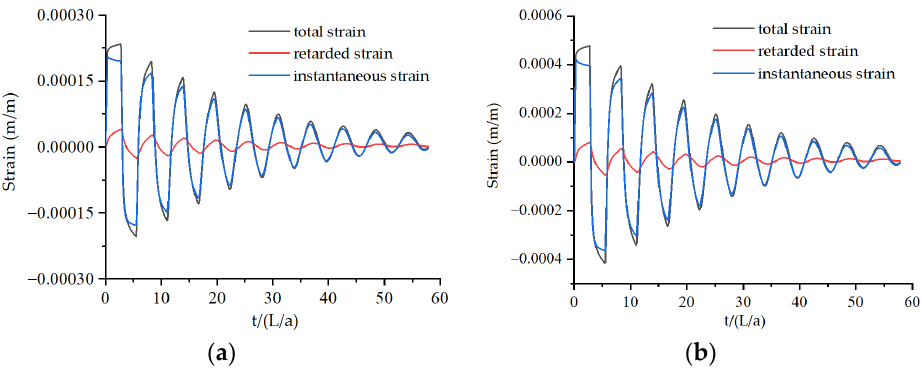
Figure 3. Results of strain at different Re values: ( a ) Re = 13,880; ( b ) Re = 28,320.